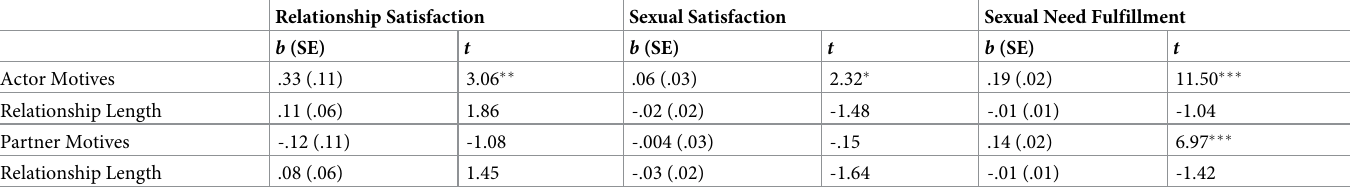
Table 7. Sexual motives predicting relationship satisfaction, sexual satisfaction, and sexual need fulfillment at a three-month